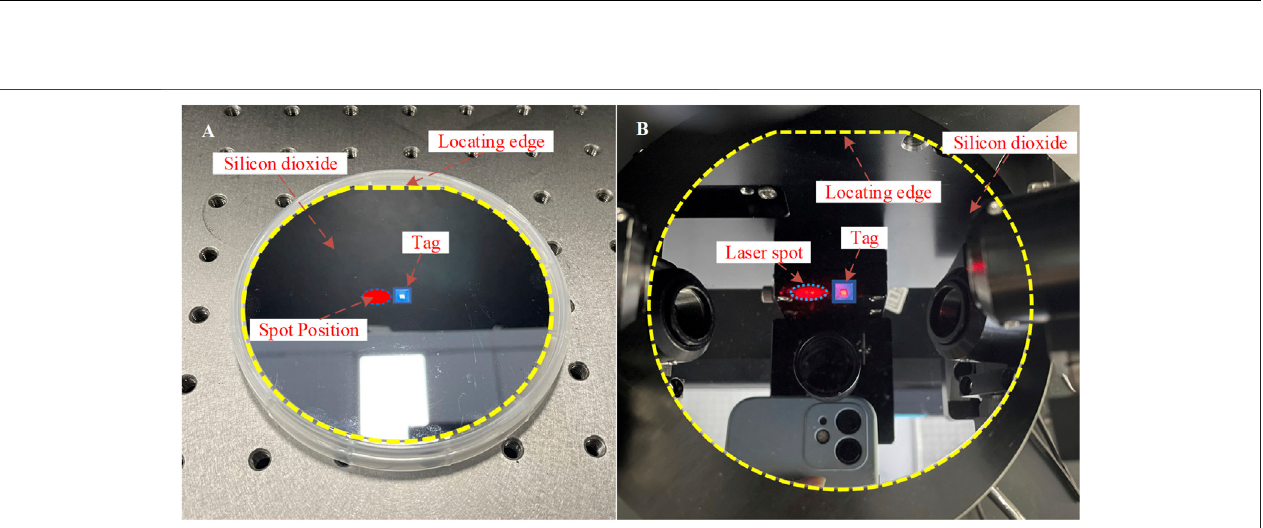
FIGURE 14 | Diagram of the point positioning (A) silicon wafer and (B) in situ